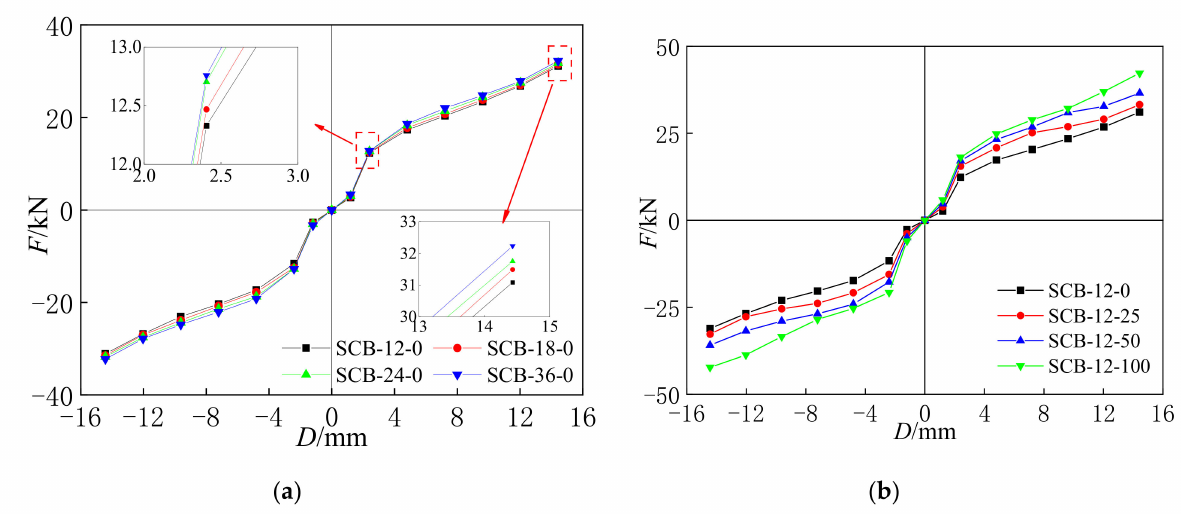
Figure 8. ( a ) Loading rate; ( b ) initial strain. Bond curves of self-centering SMA brace